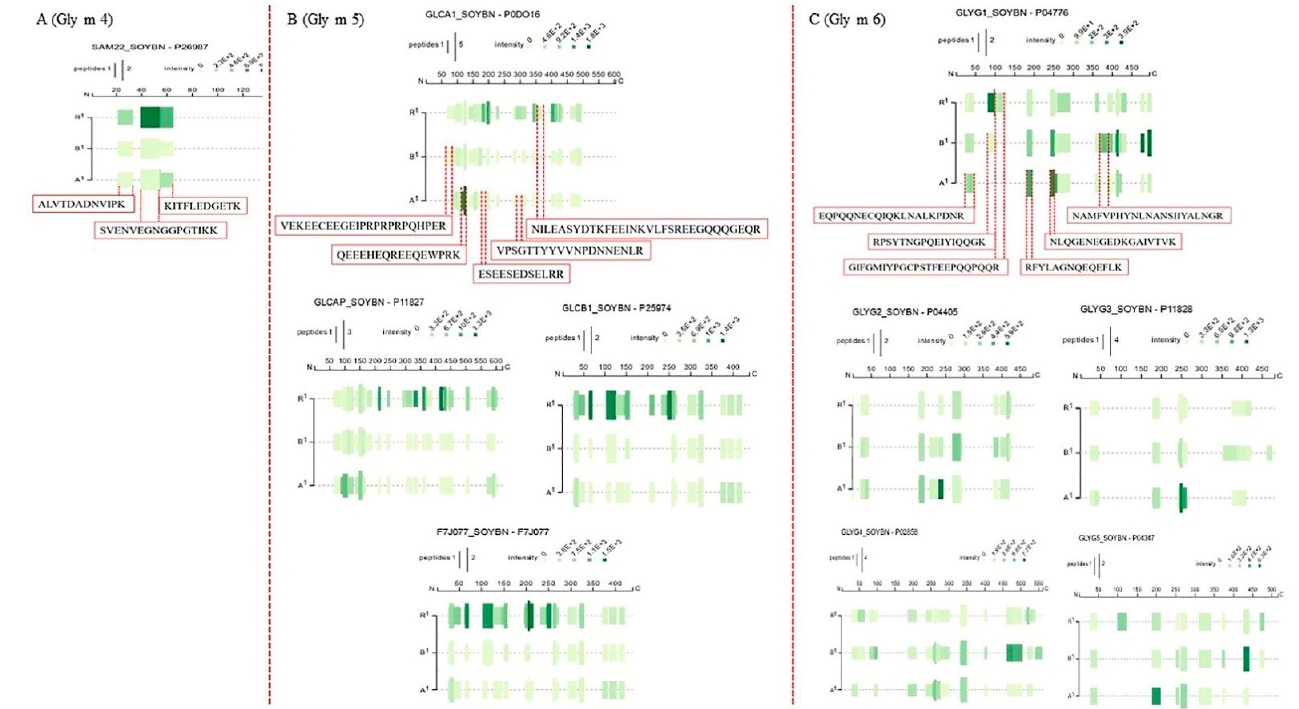
Figure 5. Changes in peptide map of Gly m 4-Gly m 6 in extracted proteins from raw (R1), boiled (B1) and autoclaved soybeans (A1). ( A ) peptide map of Gly m 4 (UniProtKB, P26987). ( B ) peptide map of Gly m 5, including beta-conglycinin alpha subunit 1 (UniProtKB, P0DO16), beta-conglycinin alpha’ subunit (P11827), beta-conglycinin beta subunit 1 (P25974) and beta-conglycinin beta subunit 2 (F7J077). ( C ) peptide map of Gly m 6, including Glycinin G1(P04776), G2 (P04405), G3 (P11828), G4 (P02858) and G5 (P04347). The relative abundance, amino acid coverage and overlap ratio was shown by the color depth, the width and length of each band, respectively.